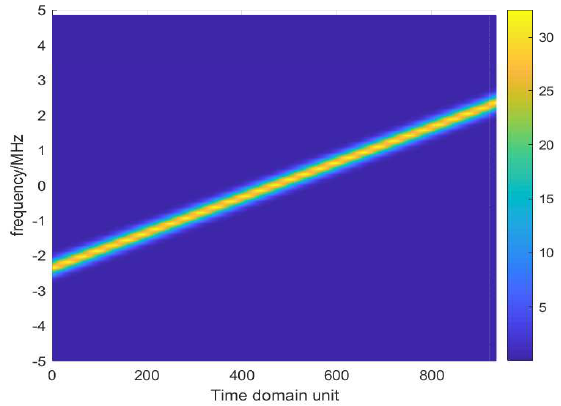
Figure 6. Time-frequency distribution of the transmitting LFM signal.